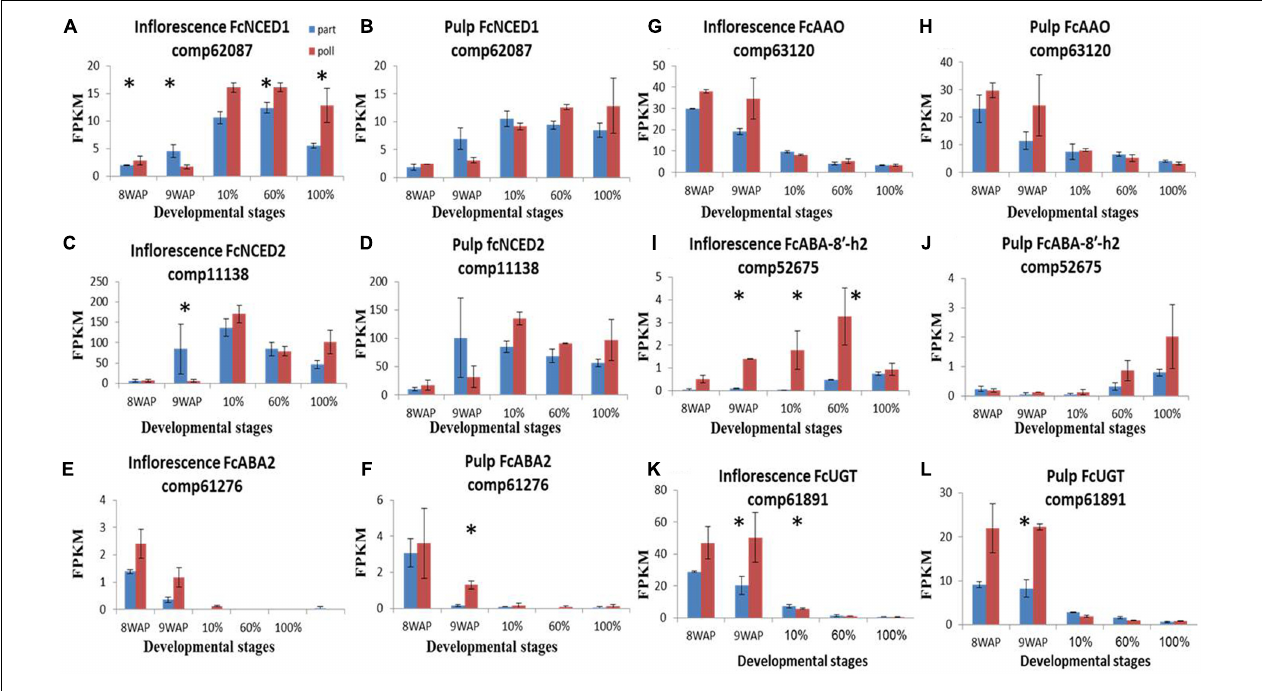
FIGURE 4 | Gene-expression pattern of six predicted ABA-metabolism genes. Genes were identified by tblastn of the ABA-metabolism genes from Arabidopsis thaliana against our Ficus carica (Fc) data and validate against Malus and the NCBI databases. (A–D) Expression levels of Fc NCED genes in inflorescence (A,C) and pulp (B,D) . (E,F) Expression levels of Fc ABA2 in inflorescence and pulp, respectively. (G,H) Expression levels of Fc AAO in inflorescence and pulp, respectively. (I,J) Expression levels of Fc ABA-8 (cid:48) -h in inflorescence and pulp, respectively. (K,L) Expression levels of Fc UGT in inflorescence and pulp, respectively. Bars represent standard error. Asterisk represent statistical significance determined using the edgeR test (FDR <